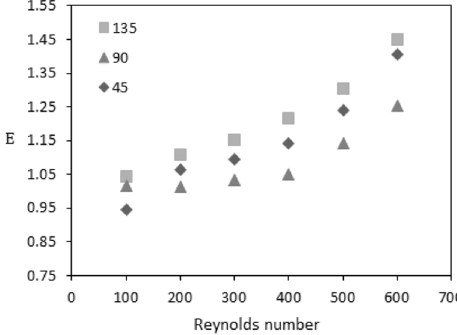
Fig. 9 Comparison of the thermal performance ratio versus Reyn- olds number in the channel with vibrating elastic beam and inclined baffles (BR = h/H = 0.4, θ = 45°, 90°, and